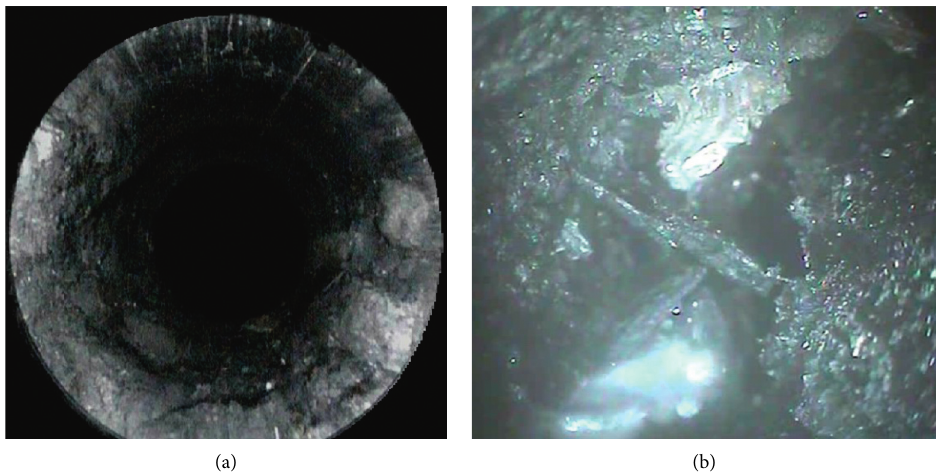
Figure 9: Borehole surface before and after liquid CO 2 fracturing blasting. (a) Before blasting. (b) After blasting.